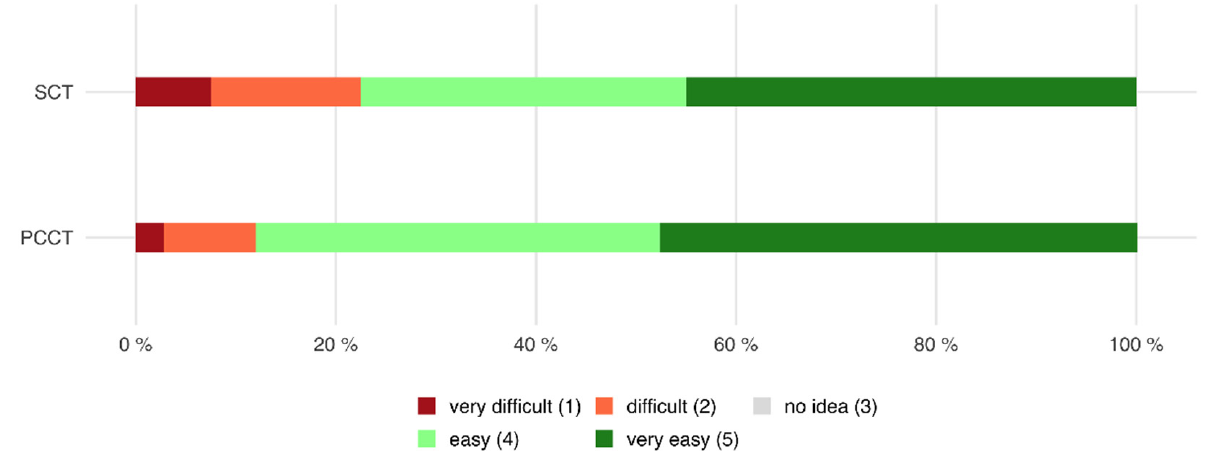
Figure 3. Horizontal stacked bar chart showing the perceived effort to lie down and get up from the CT table. Overall, only very few patients experienced difficulties lying down and getting up on both scanners, and there was no significant difference (PCCT 4.21 ± 1.0 versus SCT 4.04 ± 1.2, p = 0.447).